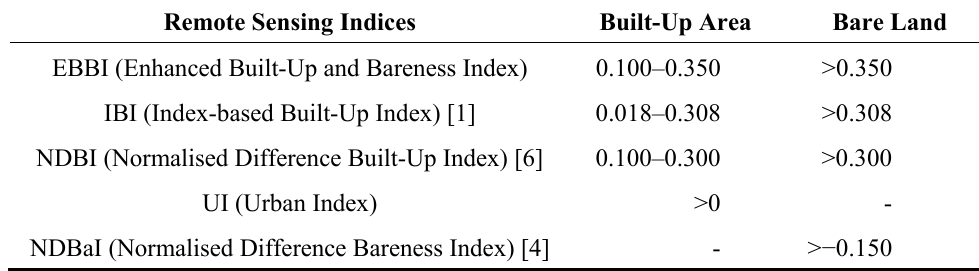
Table 2. Limitation of the index value for each type of index transformation in determining non-built-up, built-up, and bare land